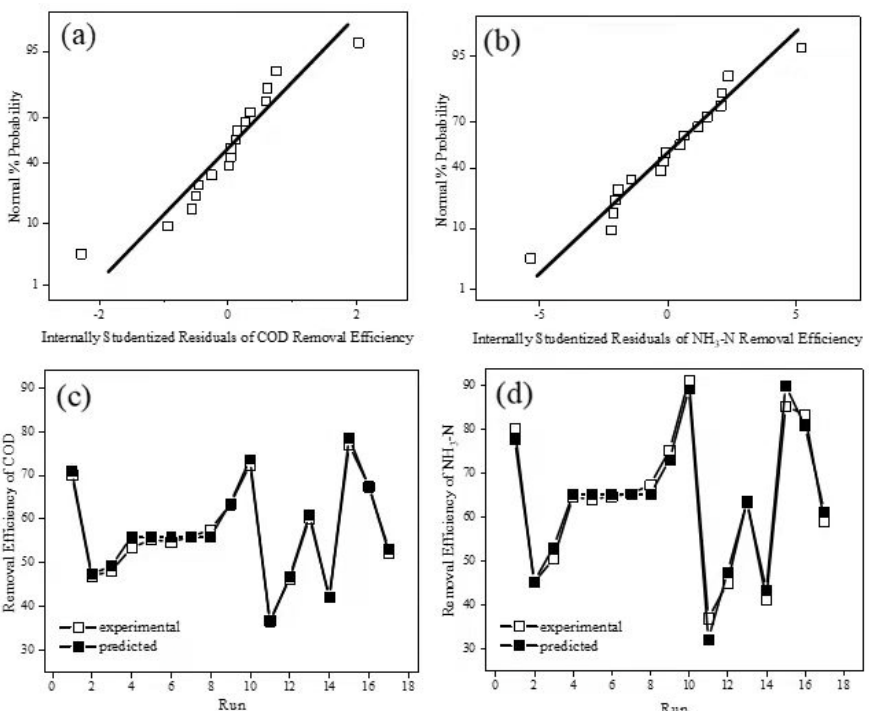
Figure 2. Normal probability plot of the internally studentized residuals for COD ( a ) and NH 3 − N ( b ) removal. Predicted versus actual values plot for COD ( c ) and NH 3 − N ( d ) removal.